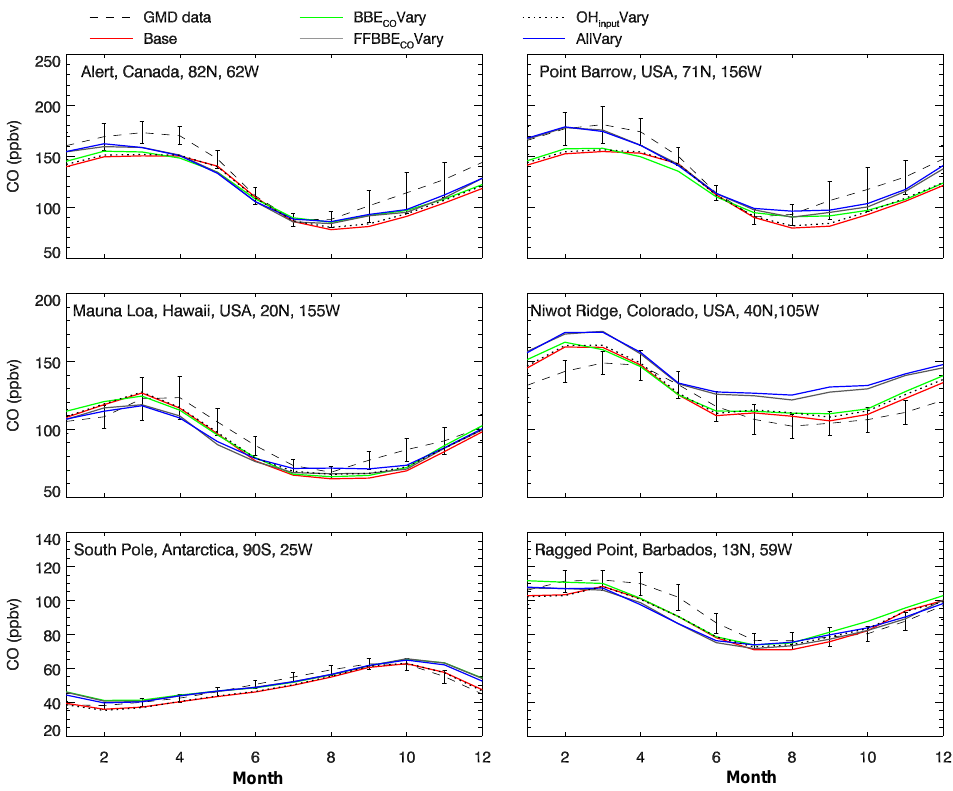
Figure 11. Monthly CO (ppbv) averaged over 1998–2007 for several scenarios and observations at six GMD stations. Vertical lines represent the standard deviation of the observed monthly mean.